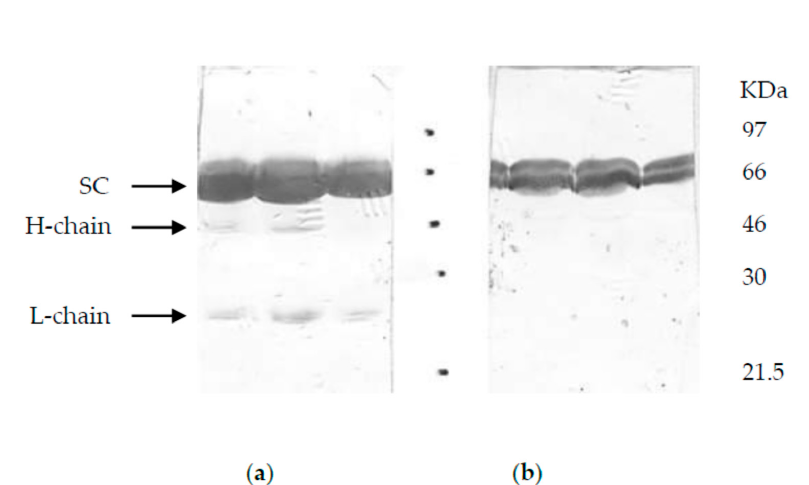
Figure 1. Western blot of badger sIgA. Badger sIgA was purified from bile by gel filtration and ( a ) probed using rabbit polyclonal antibodies to dog IgA (Bethyl Laboratories, UK) and ( b ) pan-species SC (Bethyl Laboratories, UK). Heavy (H) and light (L) chains of IgA indicated based on published sizes for other species.